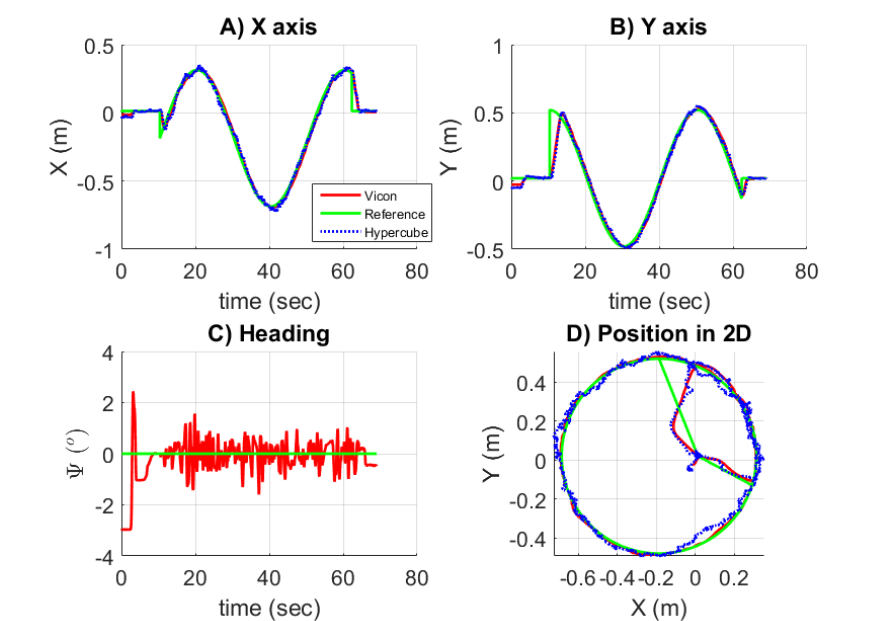
Figure 13. Plots of the position and orientation of the mobile robot. The accurate measurements provided by the Vicon system feed the sliding mode nonlinear controller. The trajectory is reconstructed using HyperCube and the IR LED that flickers at 11 kHz. The closed-loop control of the robot’s positions and heading is only based here on the measurements provided by the Vicon